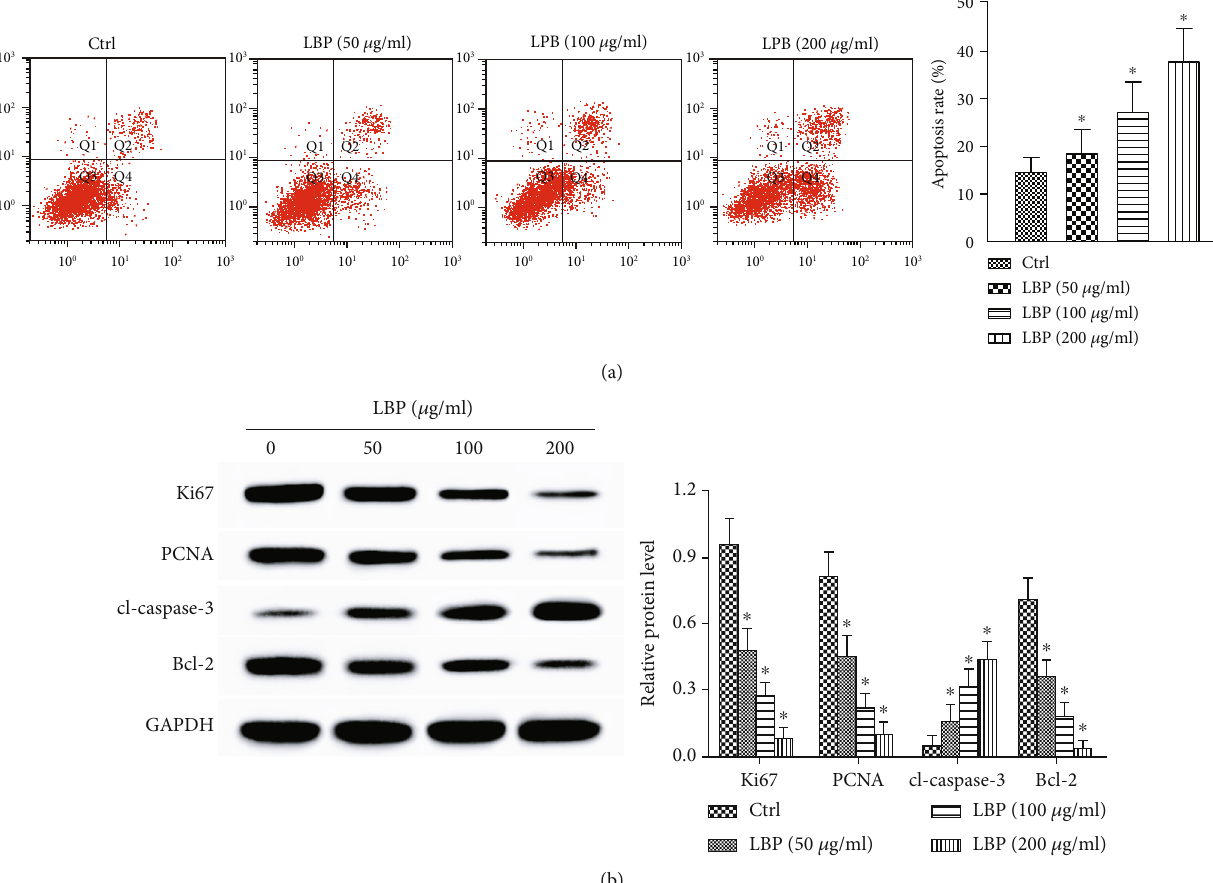
Figure 3: E ff ect of LBP on proliferation- and apoptosis-related protein expression in A431 cells. (a) Apoptosis rate of A431 cells was detected by fl ow cytometry. (b) Expression of apoptosis-related proteins in A431 cells was detected by Western blot. Compared with the control group, ∗ P < 0 : 01